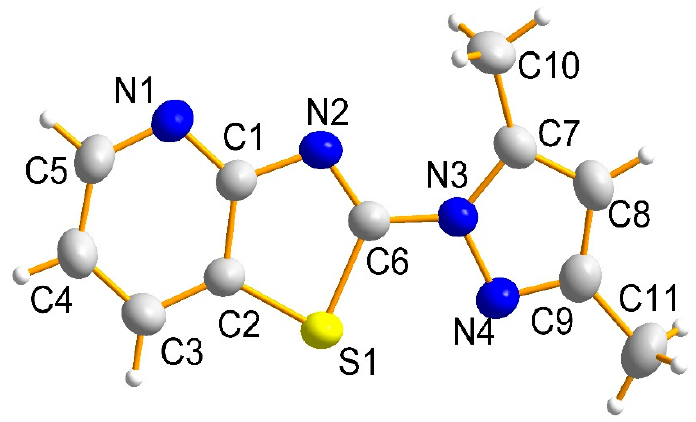
Figure 1. The molecular structure of 1 showing atom labeling and displacement ellipsoids at the 50% probability.